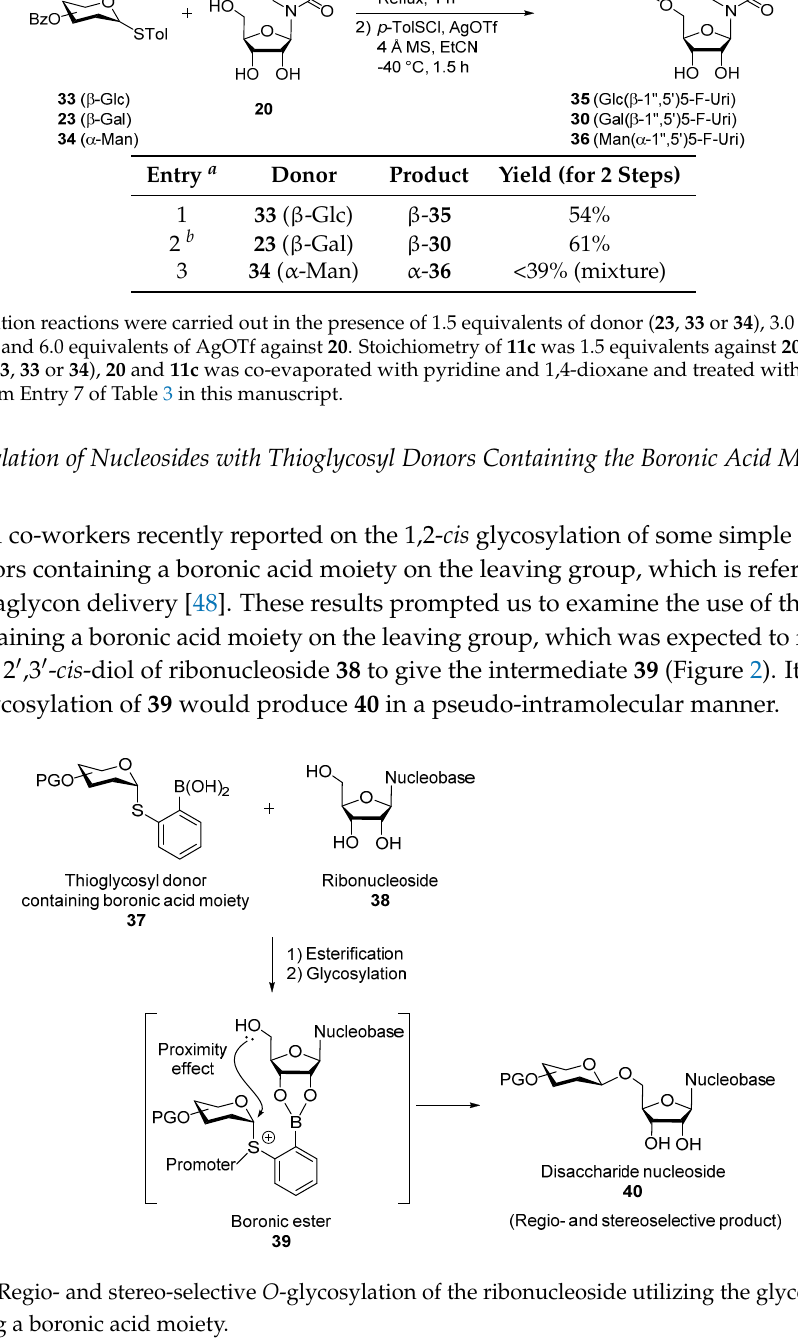
Figure 2. Regio- and stereo-selective O -glycosylation of the ribonucleoside utilizing the glycosyl donor containing a boronic acid moiety.